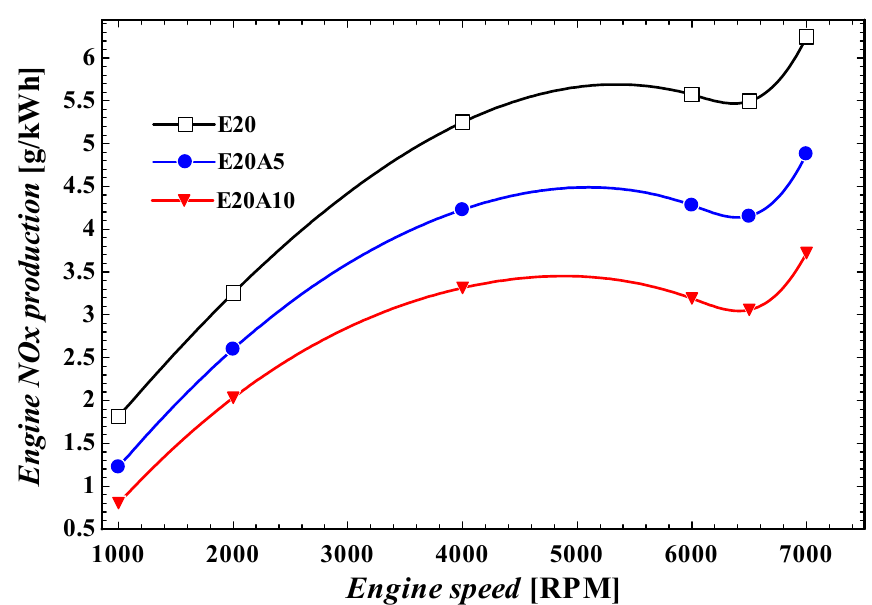
average at various engine speeds for E20.